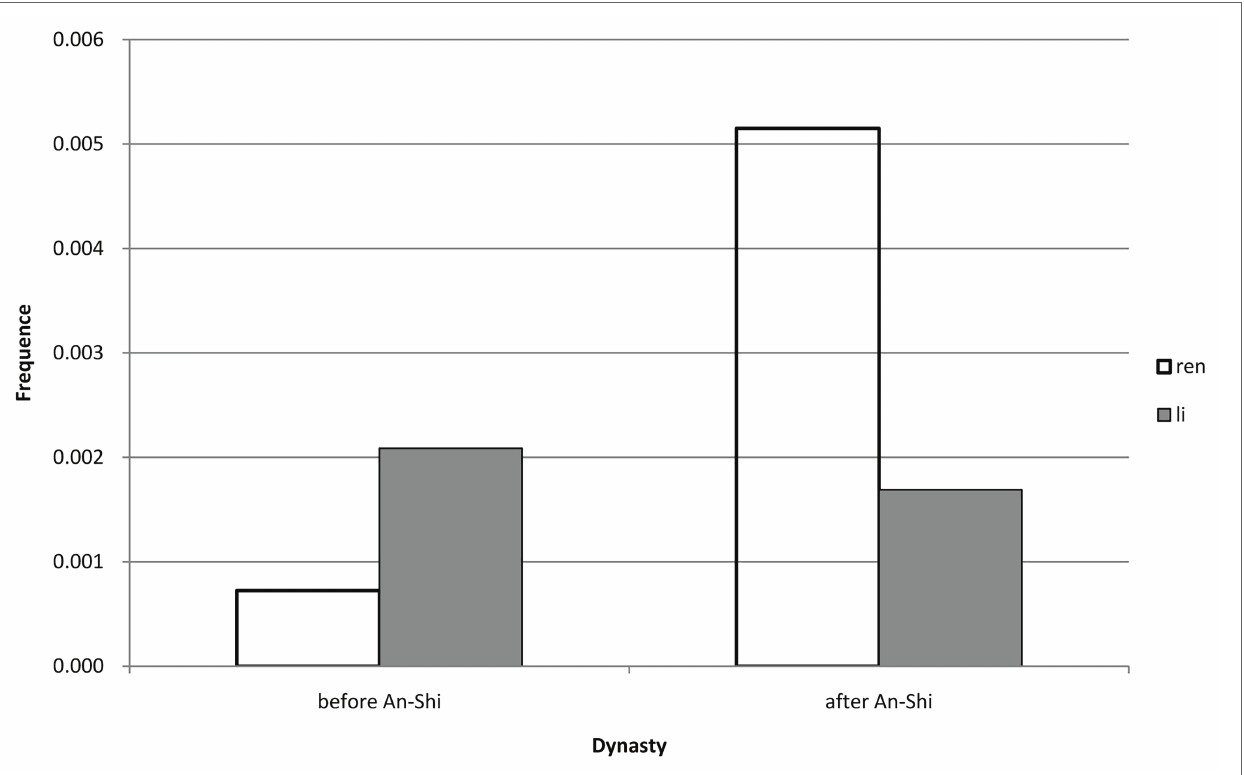
FIGURE 3 | The difference before and after An-Shi disturbances in Tang